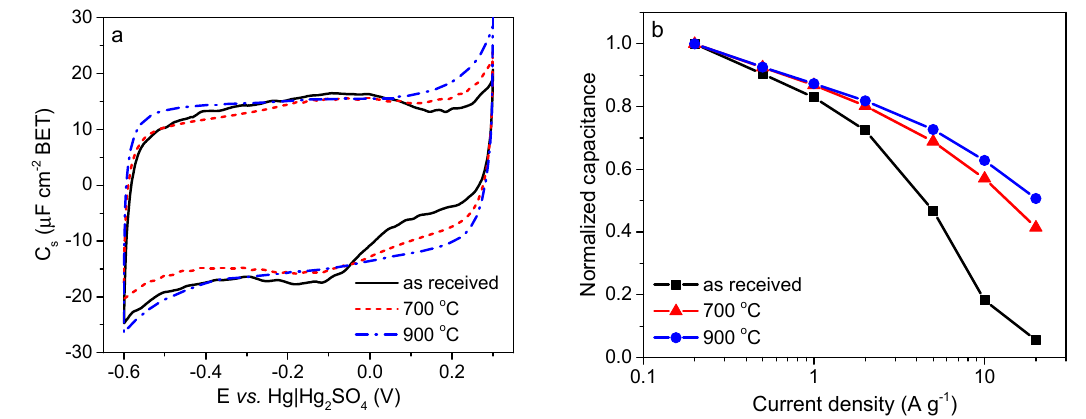
Figure 27. CV curves ( a ) and rate capability ( b ) of the as received H 3 PO 4 activated carbon and the products of heat-treatment at 700 and 900 ◦ C in nitrogen. The properties were evaluated in a 3-electrode system in 1 mol L − 1 H 2 SO 4 as an electrolyte. CV scan rate: 2 mV s − 1 .